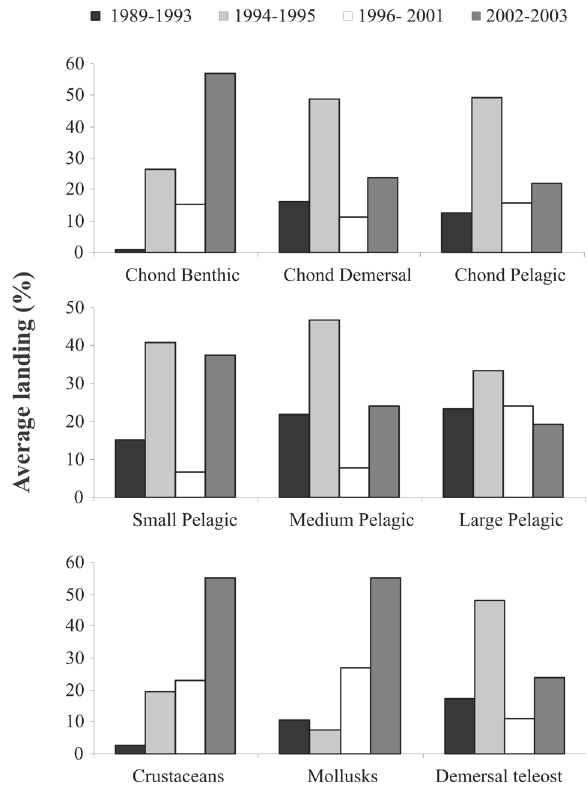
ig . 5. – Average landing (t in %) of species groups (Chon: chon- dricthyes; dem: demersal teleost,) within the main time blocks de- fined (black, 1989-1993; light grey, 1994-1995; white, 1996-2001; grey